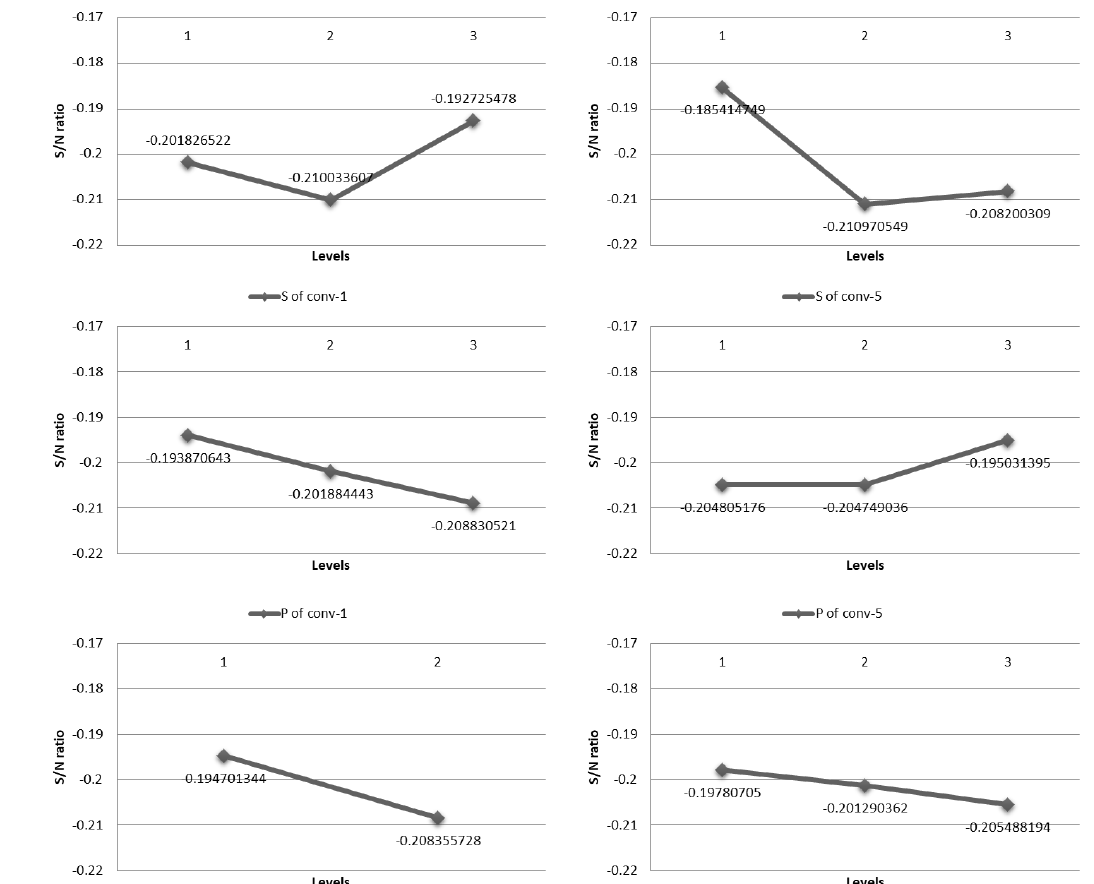
Figure 7. E ff ects of all factors in the MORPH database. Figure 7. Effects of all factors in the MORPH database. Table 9. Average S/N ratio of each factor and level in MORPH database.